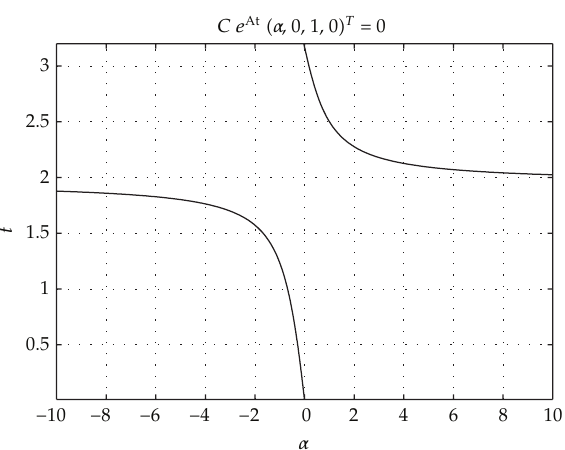
Figure 4: First resetting time as a function of α